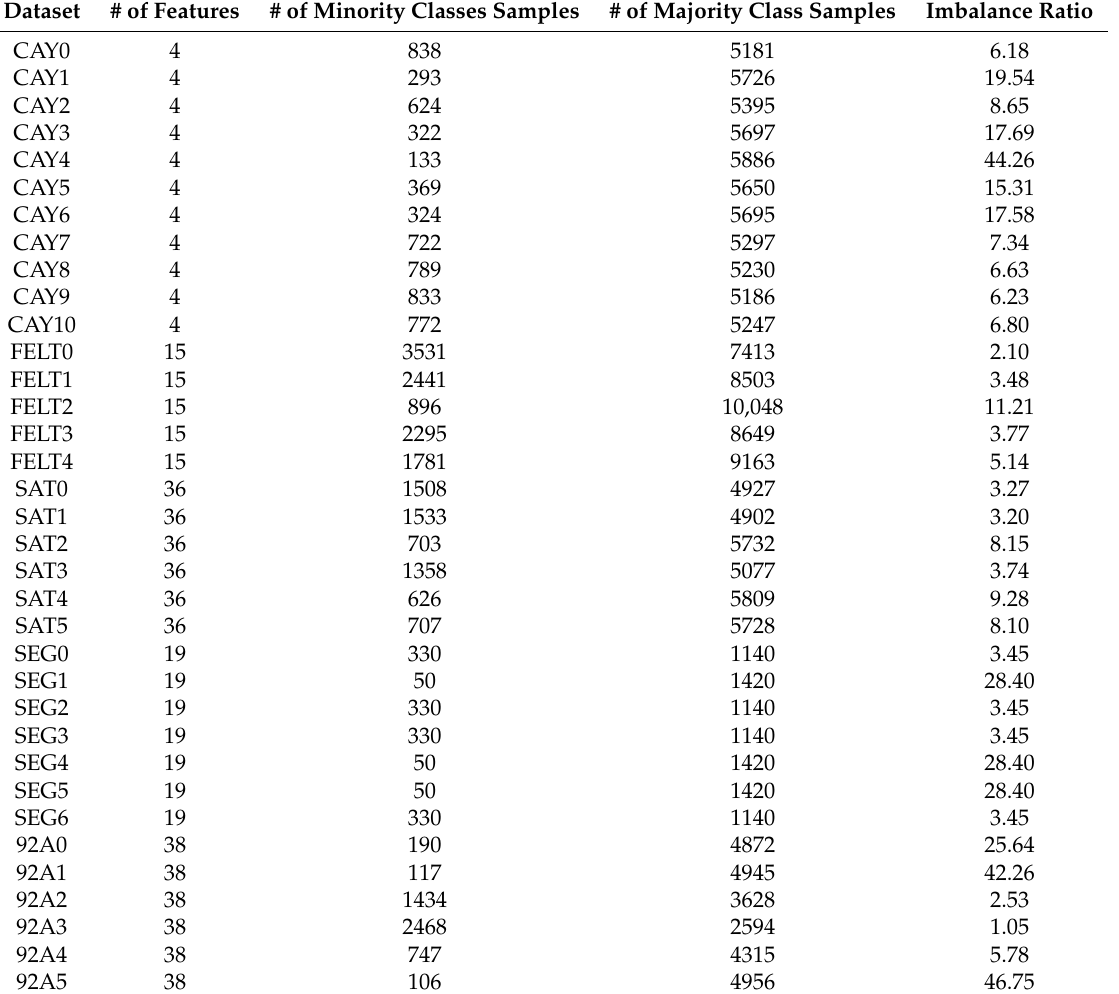
Table 1. A brief summary of the main characteristics of the new produced benchmarking